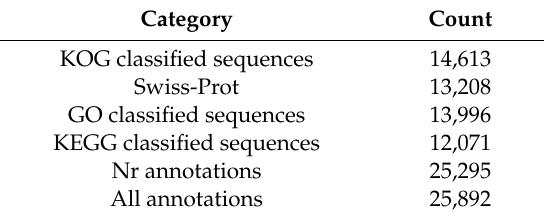
Table 1. Annotation of the assembled gene fragments of bighead